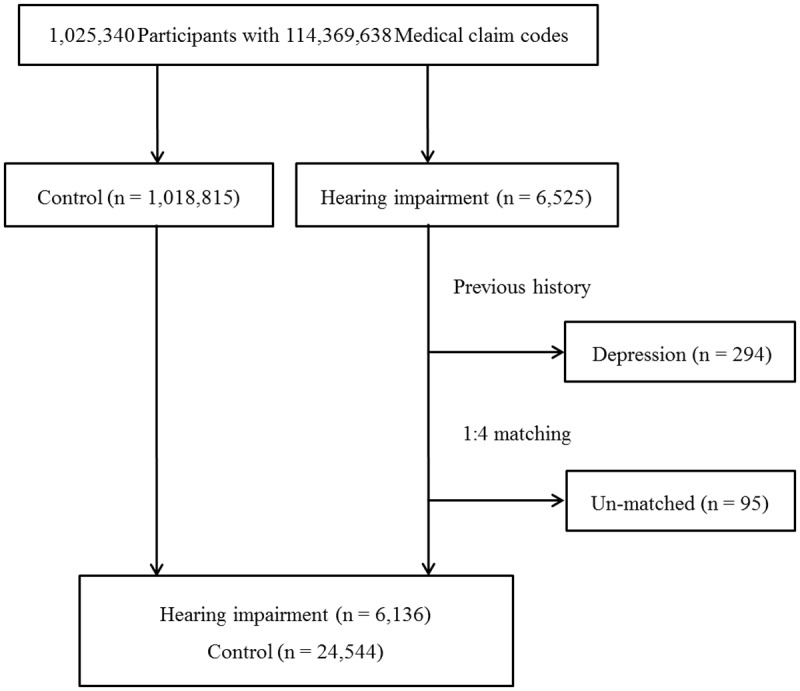
A schematic illustration of participant selection in the present study.Among a total of 6,525 hearing impaired participants, participants who had a history of depression before hearing impairment (n = 294) and could not find enough matching participants (n = 95) were excluded. The data for the 6,136 of hearing impaired participants and 24,544 control participants were analyzed.